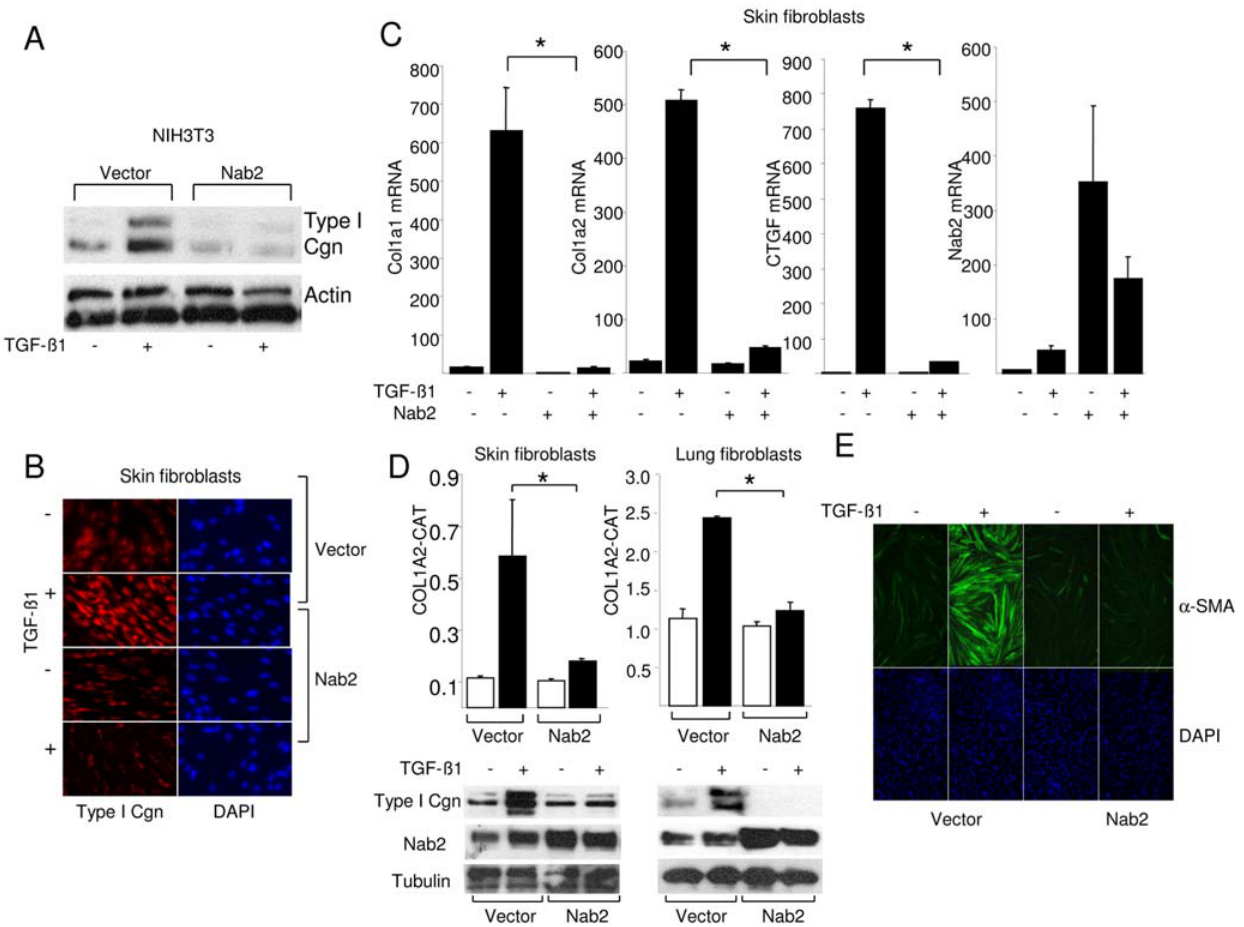
Figure 2. Nab2 abrogates TGF- b responses. Cultures of fibroblasts were cotransfected with Nab2 expression vectors or empty vector and harvested following incubation with TGF- b 1 for 24 or 48 h. A. Whole cell lysates were examined by Western analysis. Representative immunoblots. B. Fibroblasts were fixed, incubated with antibodies to Type I collagen, and examined by immunofluorescence microscopy (original magnification 6 400). Nuclei were identified by DAPI (blue). C. Total RNA was isolated and examined by real-time qPCR. Results, normalized with actin, are the means 6 S.D. of triplicate determinations from a representative experiment. D. Fibroblasts were cotransfected with 772COL1A2-CAT. Cell lysates were assayed for their CAT activities (upper panels) or examined by Western analysis (lower panels). Results of CAT assays, normalized with Renilla luciferase, are expressed as means 6 S.D. of triplicate determinations from a representative experiment. Open boxes, untreated fibroblasts; closed boxes, TGF- b -treated fibroblasts. *p , 0.005. E. After 48 h fibroblasts were fixed, incubated with antibodies to a -SMA (green) and examined by immunofluorescence microscopy. Nuclei were identified by DAPI (blue). Representative images (original magnification 6 100).